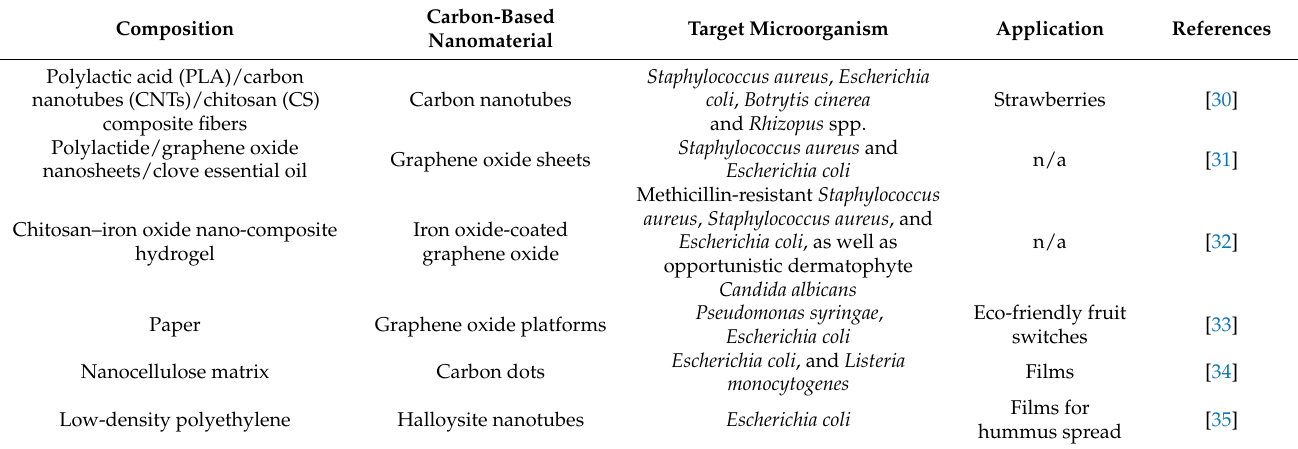
Table 1. Applications of carbon-based nanofillers for cosmetics and food